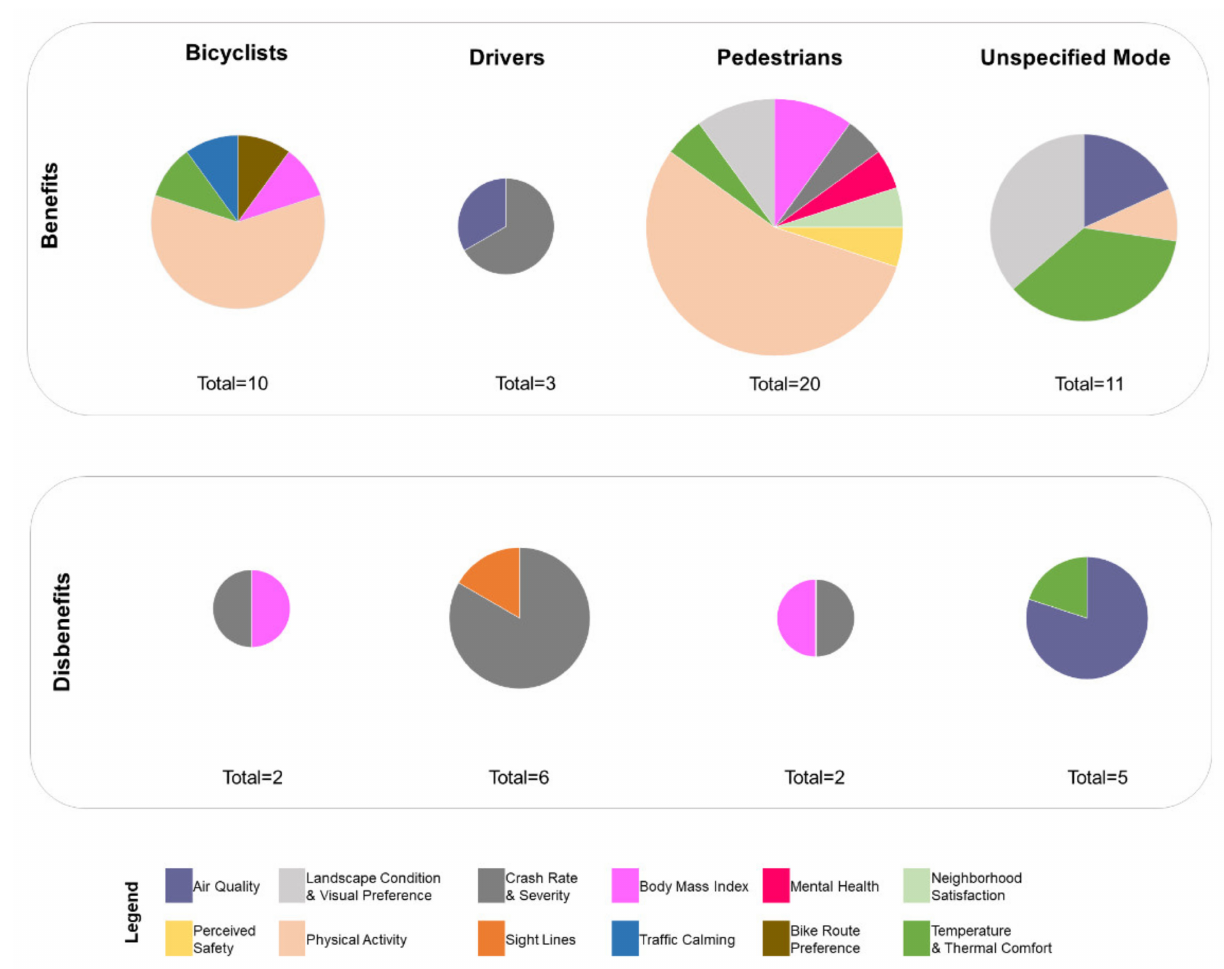
Figure 6. Number of findings of health/safety benefits and disbenefits of street trees by circulation mode proportional to